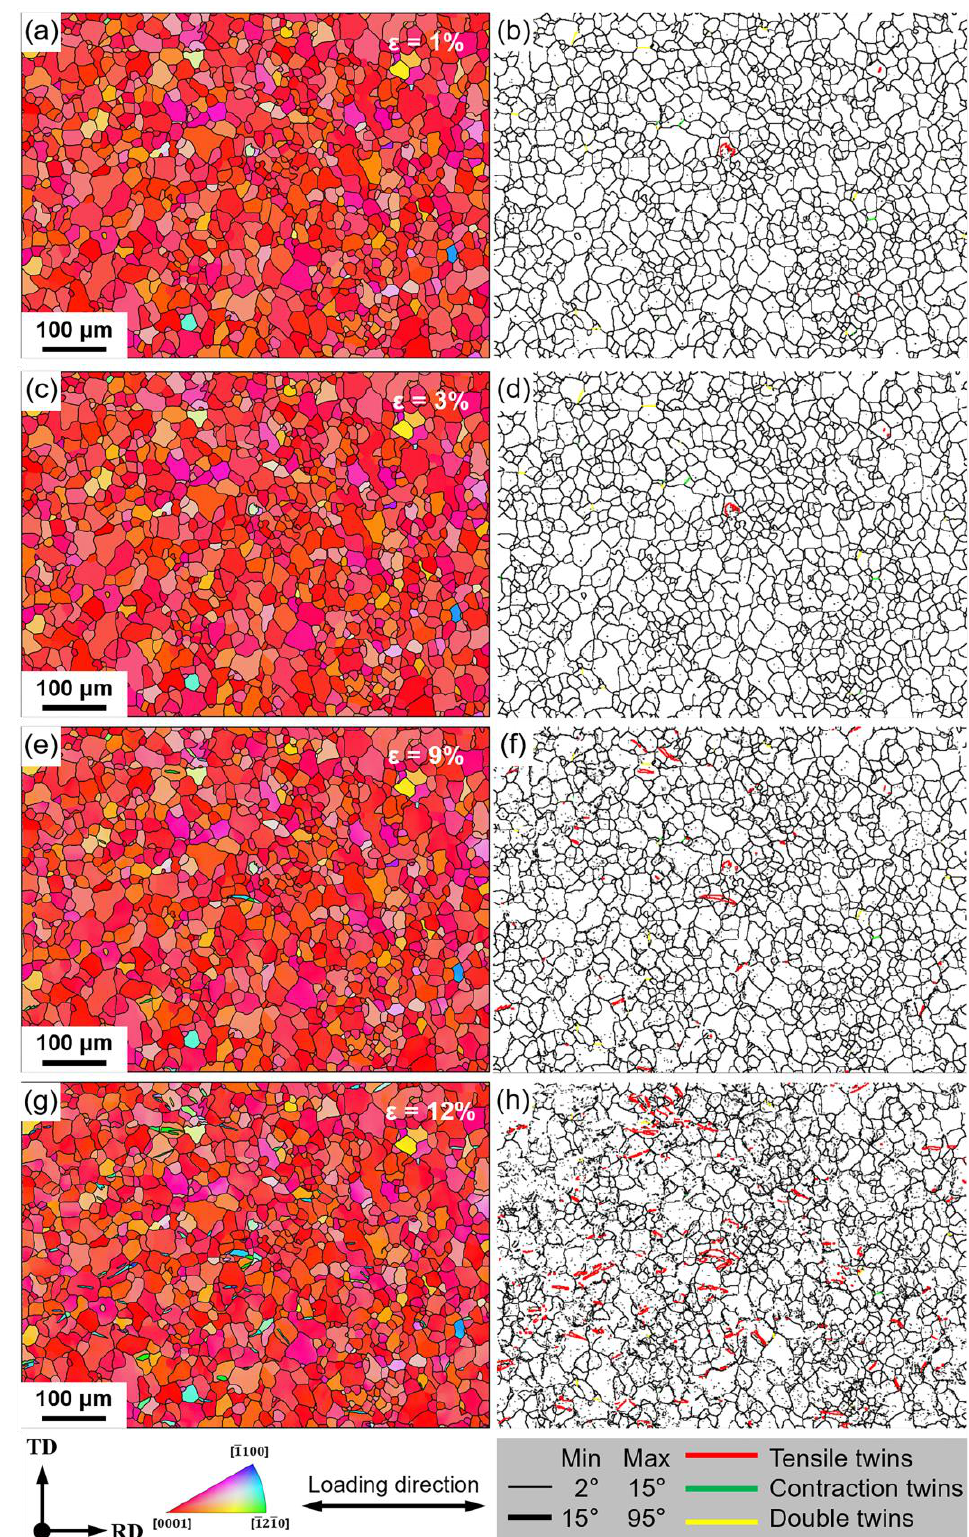
Figure 6. Quasi in situ EBSD evolution results of rolled AZ31 alloys in the tensile direction: ( a , c , e , g ) the IPF maps and ( b , d , f , h ) special grain boundary diagrams at different stages. ( a – d ) From the IPF maps and special grain boundary diagrams, it is evident that none of the twinning presents at a low strain level (strain <3%). ( e – h ) The small portion of twinning emerged inside some grains when the strain surpasses 9%.